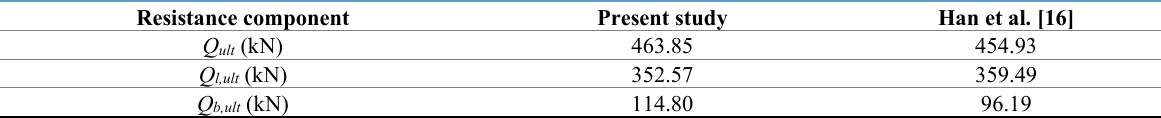
Table 1. Ultimate total, lateral and base resistances ( w / D = 10%).